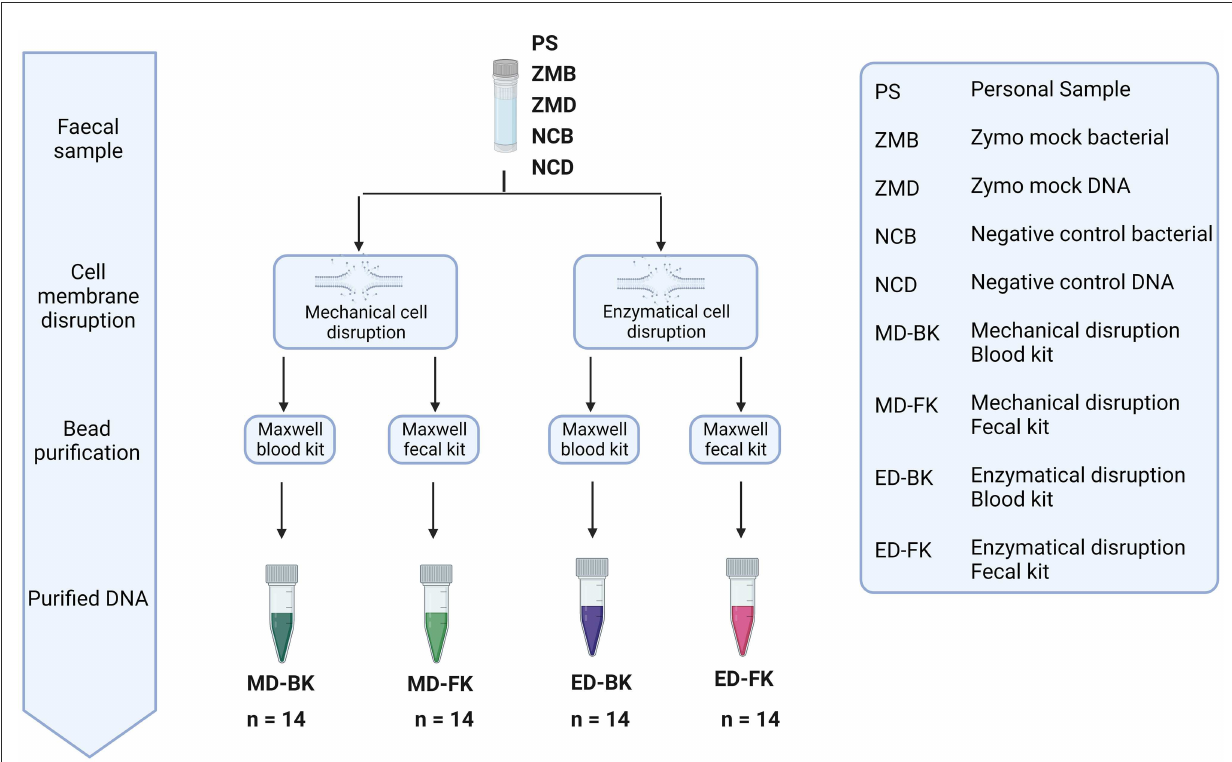
FIGURE5 Overview of the different methods for DNA extraction. Personal samples of five donors were stored under two conditions, one aliquot was directly frozen ( − 80-ZYCON), and the other aliquot of the sample was stored at RT for 3–5 days in Zymo research collection tubes (RT-ZYBUF). These fecal samples, together with two positive and two negative controls were used to test the effect of mechanical or enzymatical cell disruption. Furthermore, we looked into the difference in DNA purification using the Maxwell ® RSC Whole Blood DNA Kit and the Maxwell ® RSC Fecal Microbiome DNA